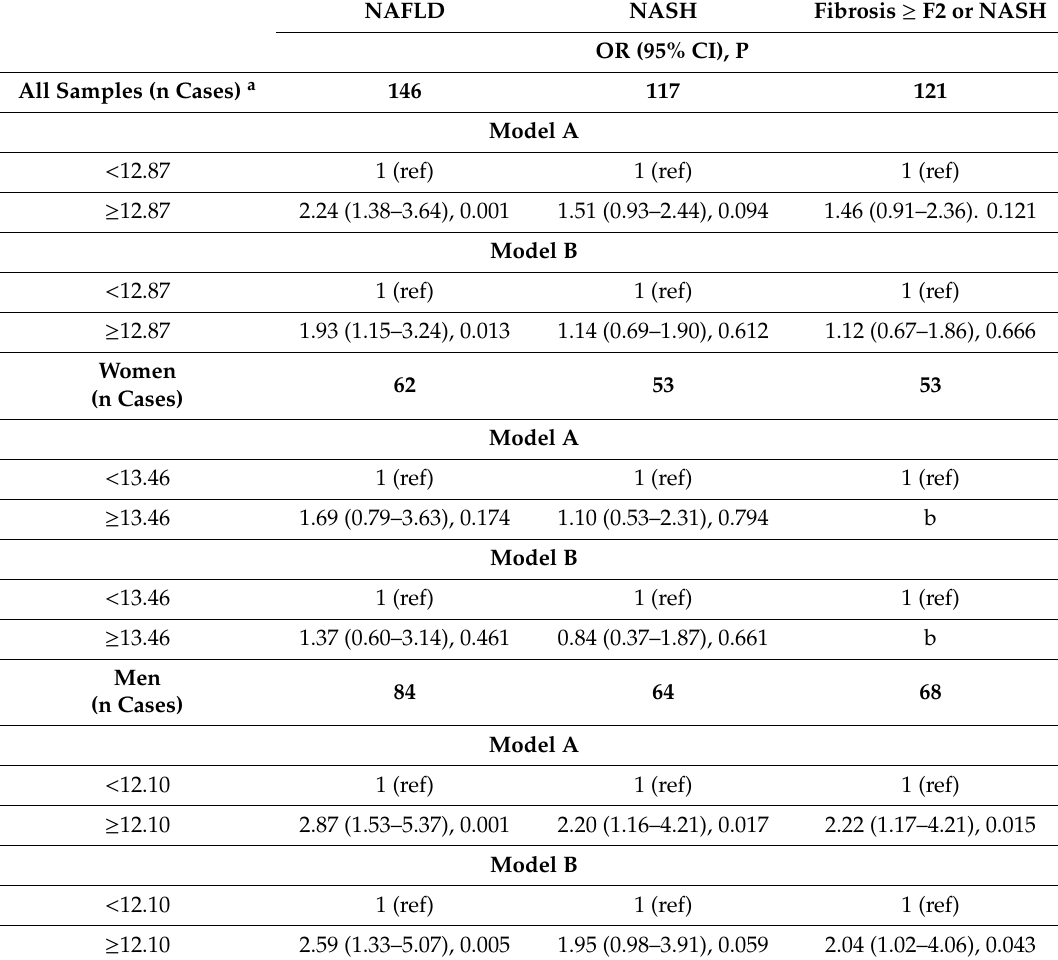
Table 2. Multivariate association of serum MDA concentration (nM) and presumed related liver damage. NAFLD NASH Fibrosis ≥ F2 or NASH OR (95% CI),